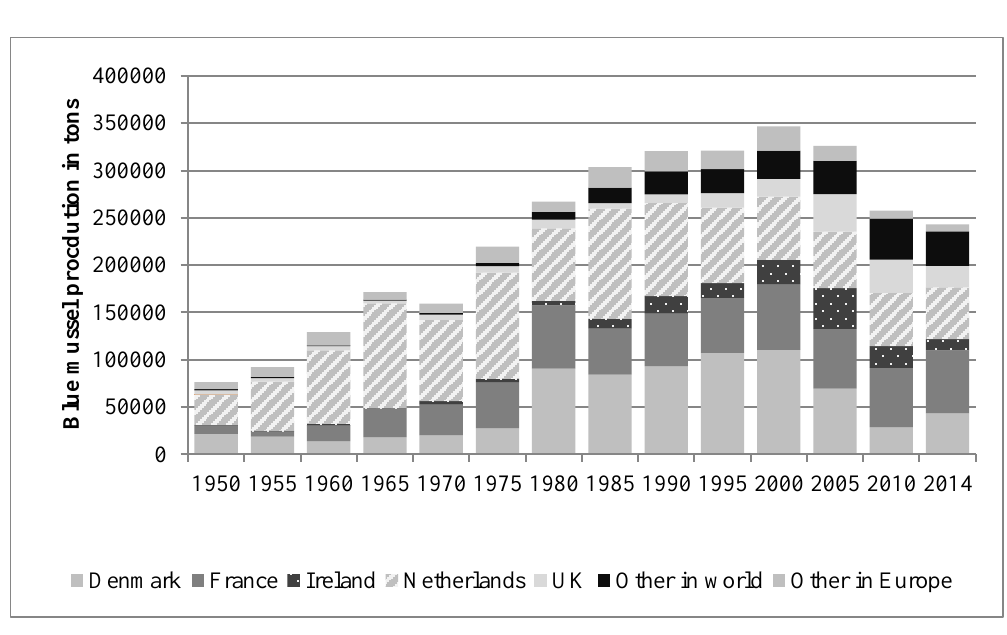
Fig. 4. Fishing of blue mussel in the world in 1950‒2014 in tons (Developed by author; FAO data,